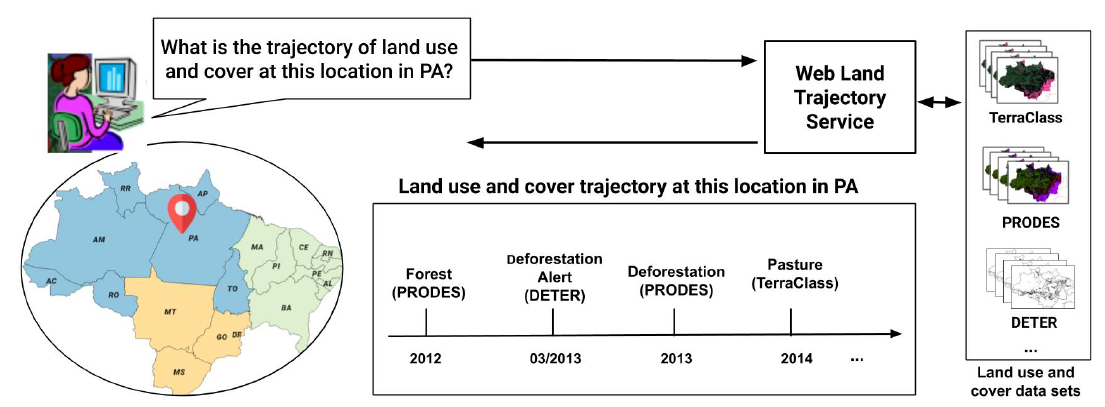
Figure 6. Web Land Trajectory Service